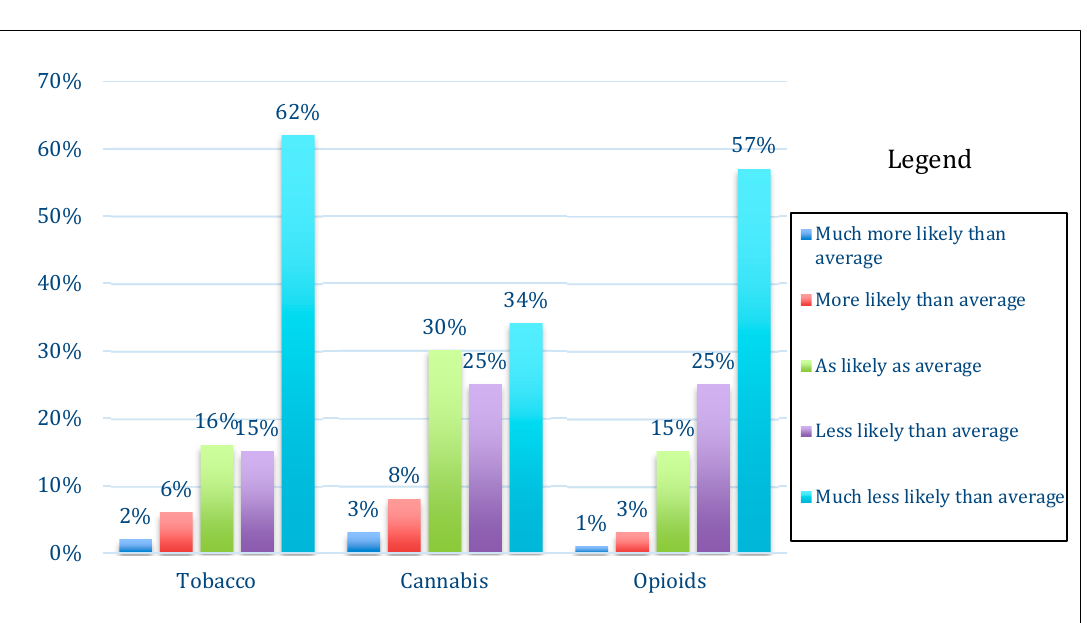
Table 2. Parental likelihood of being optimistic over their child’s use of tobacco, cannabis, and opioids before age 18 ( n = 400) 1 .